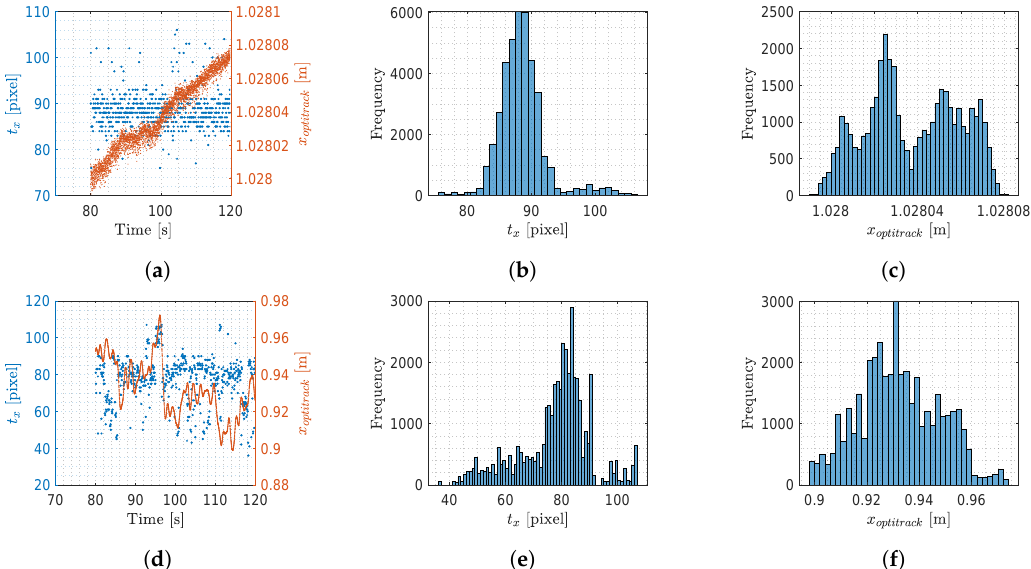
Figure 6. Results from the two experiments where the drone was stationary and in steady flight, this data is with respect to t x . ( a ) Stationary test, raw data of t x ; ( b ) Stationary test, histogram of t x ; ( c ) Stationary test, histogram of x optitrack ; ( d ) Steady flight test, raw data of t x ; ( e ) Steady flight test, histogram of t x ; ( f ) Steady flight test, histogram of x optitrack .